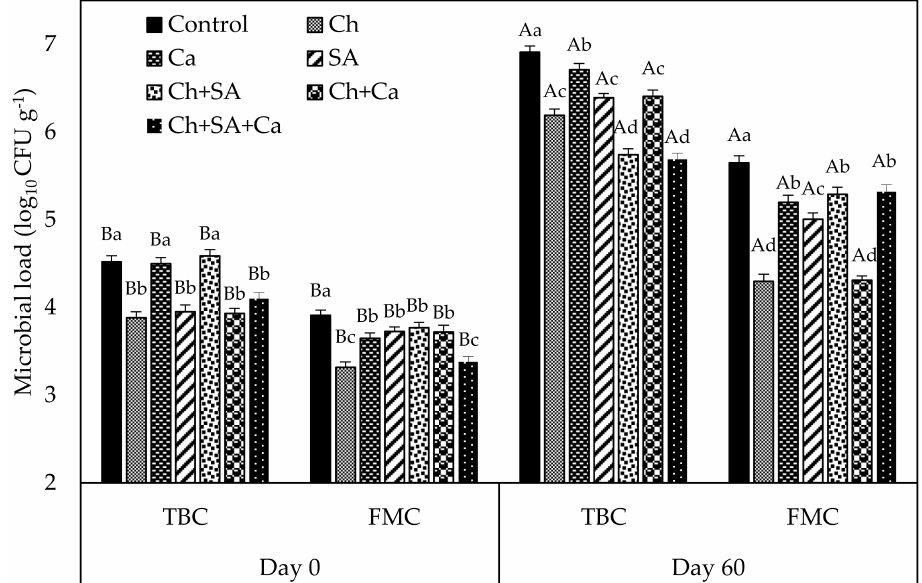
Figure 7. Effects of preharvest application of natural elicitors on microbial counts (Log 10 CFU g − 1 ) on “Barhi” date fruits during cold storage for two months; values are the mean (n = 3) ± SE. The LSD test at p ≤ 0.05 was used to compare the means between treatments. Means with the same letter(s) between treatments within storage time intervals (small letter) and at different time intervals (capital letter) are not significantly different. Ch: chitosan; SA: salicylic acid; Ca: calcium